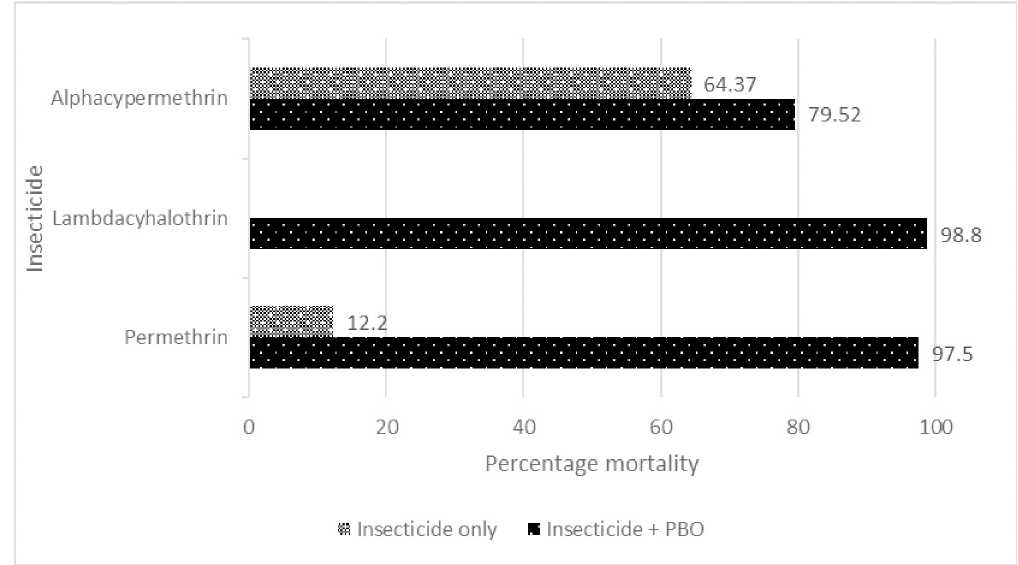
Fig 1. Percentage mortality of Culex quinquefasciatus population from Dutse LGA exposed to PBO and selected